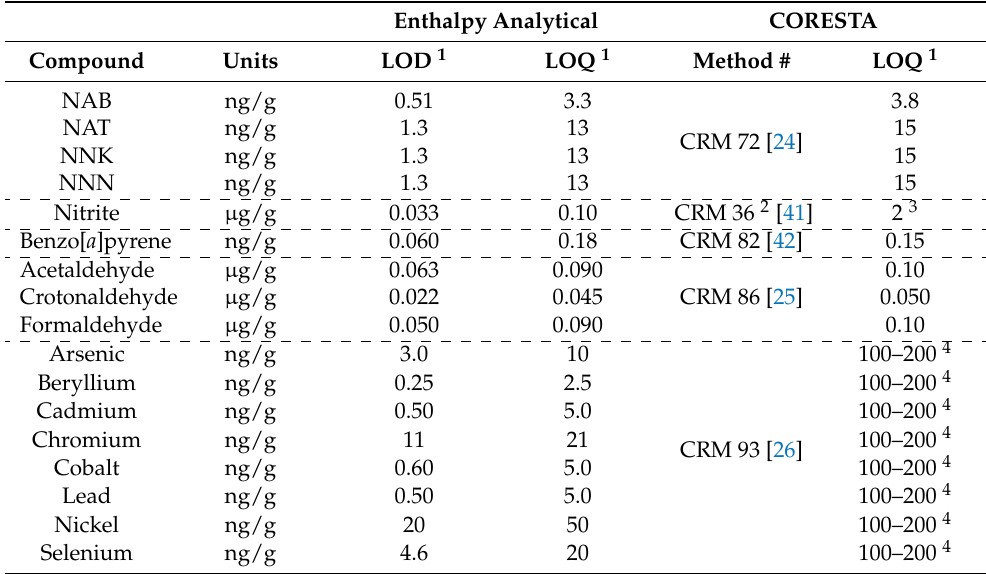
Table 7. Limits of detection and quantitation for Enthalpy’s in-house analytical methods (see Section 2.3) and the analogous CRM quantitation limits (note: CRMs do not provide LODs). Enthalpy